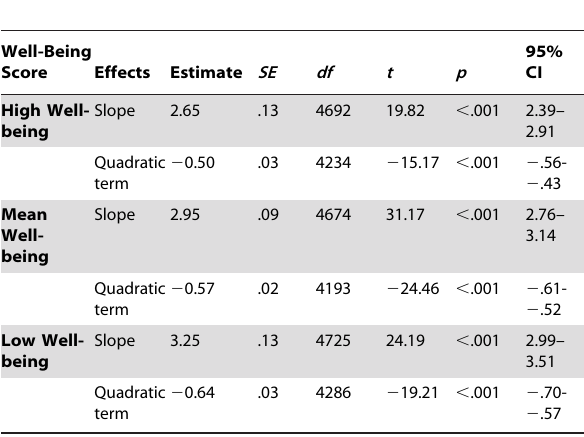
Table 4. Effect estimates for continuously measured well- being predicting depressive